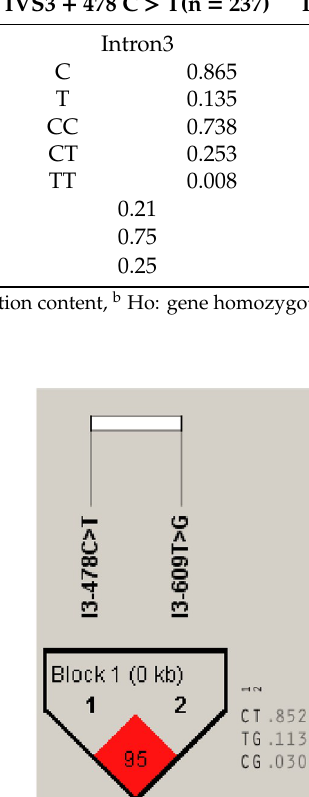
Table 2. SNPs of the DLK1 gene in Chinese Simmental.